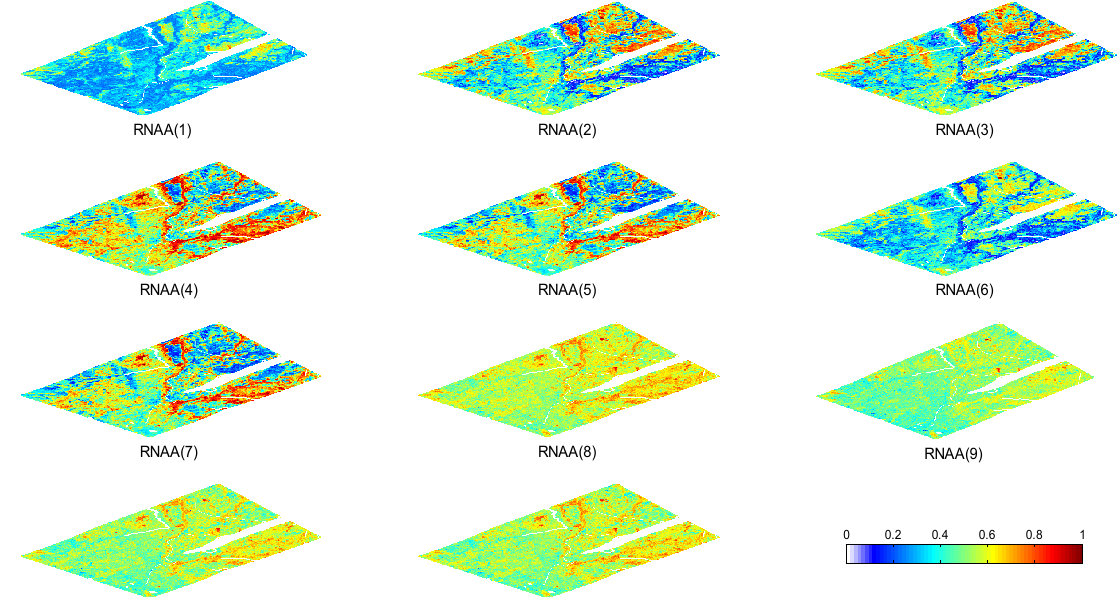
Figure 3. Age-attribute mapping of the study area with different HyMap metric combinations, given in Table 2 and learned by the RNAA. The color bar represents the relative scores scaled to a range of 0–1.